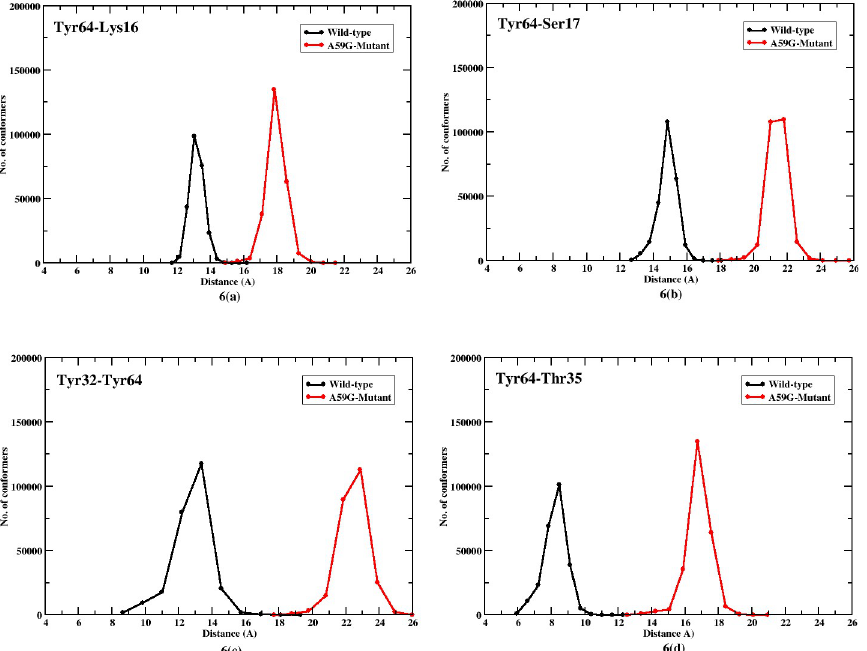
Fig 6. 2-D plot showing number of conformers for Tyr64 residue’s interaction with Lys16, Ser17, Thr35 and Tyr32. Black and red lines represent trends for the wild-type and mutant systems, respectively.